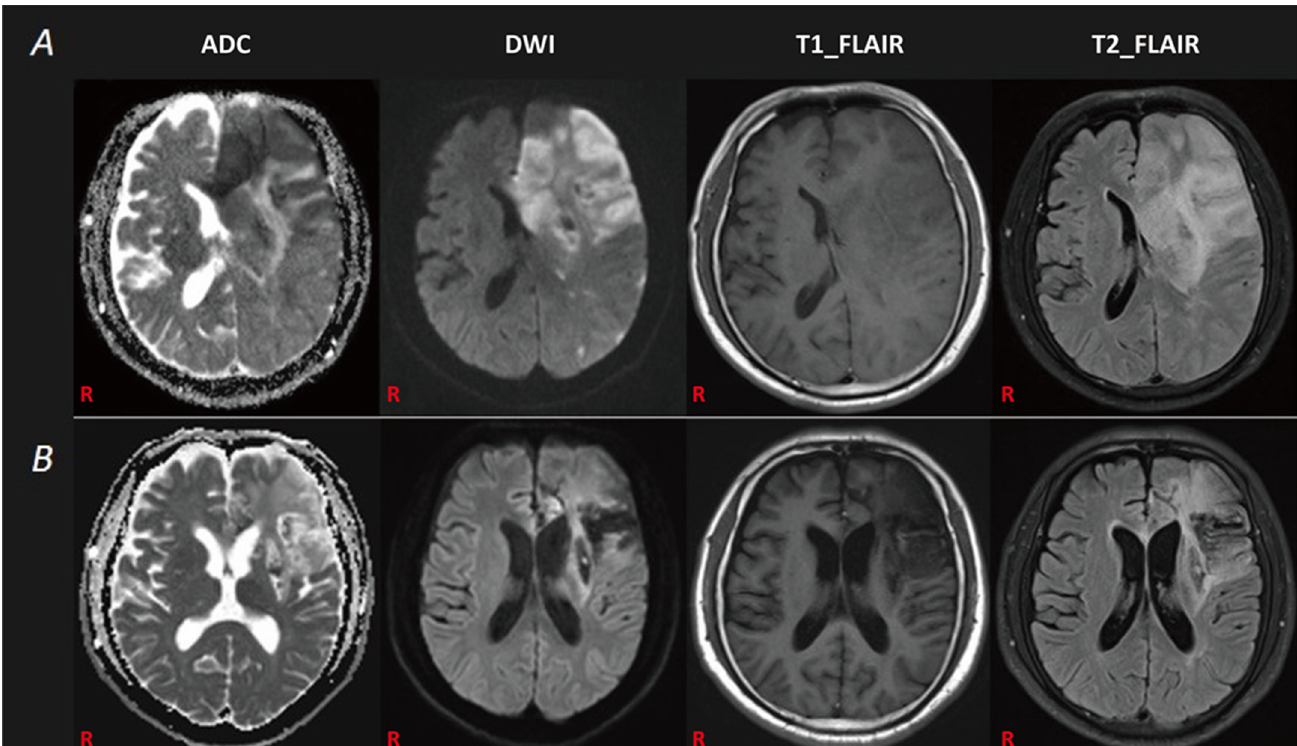
Figure 1. The patient’s MRI data. ( A ): The first brain MRI revealed an infarction lesion in the left cerebrum with a left basal ganglia hemorrhage. ( B ): The follow-up brain MRI demonstrated an old infarction lesion in the left cerebral hemisphere.